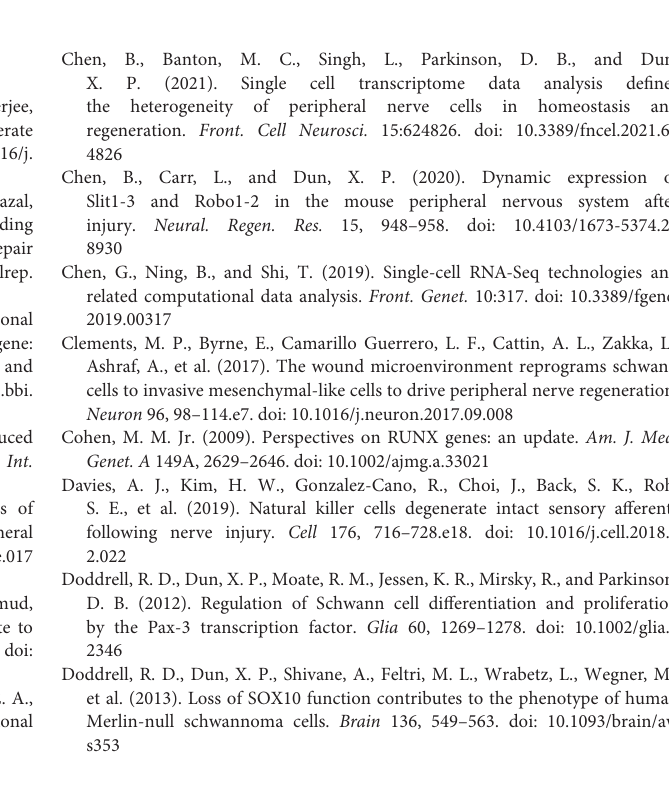
Supplementary Figure 1 | Networks for Bach1, E2f1, E2f3, Fosl1, Jun, Runx2, Sox2, Sox4, and their target genes in Schwann cells at day 3 post-injury. Supplementary Figure 2 | Networks for Atf3, Fosl1, Hmga1, Hmga2, Sox2, Sox4, and their target genes in Schwann cells at day 9 post-injury. Supplementary Table 1 | TFs with at least twofold upregulation at day 3 post-injury in microarray data sets GSE22291, GSE74087, and GSE136958. Supplementary Table 2 | TFs with at least twofold upregulation at day 7 post-injury in microarray data sets GSE22291, GSE74087, and GSE38693. Supplementary Table 3 | Expression abundance in each cell type for the identified 51 TFs at day 3 post-injury. Supplementary Table 4 | Expression abundance in each cell type for the identified 55 TFs at day 9